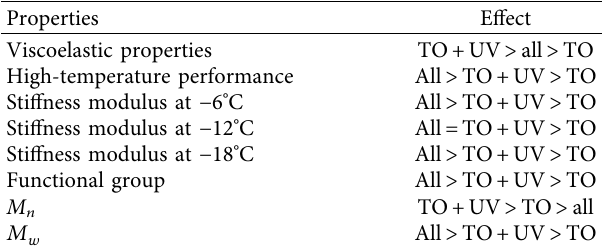
Table 2: The effect degree of different natural aging methods on the properties of asphalt